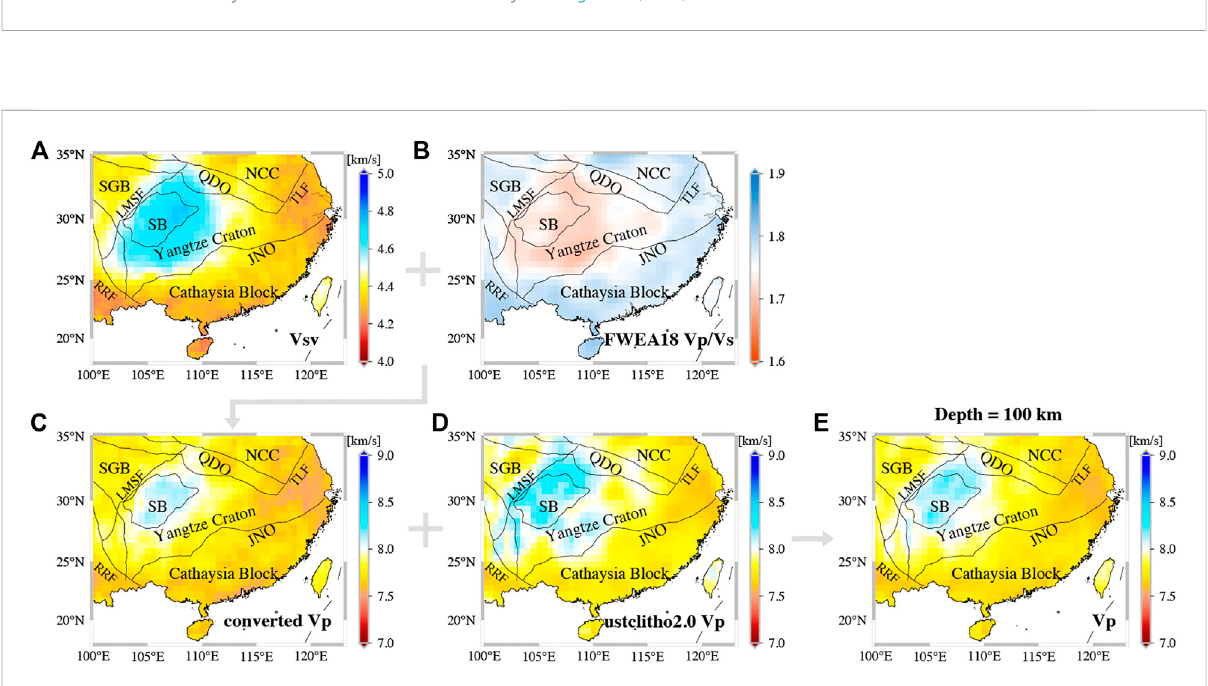
FIGURE 9 TheconstructionprocessofPwavevelocityofthemantlecomponentofSREM-SCkeyedatamapviewof100 kmdepth (C) TheconvertedPwave modelisobtainedbycombing (A) theaveragedSVwavemodelwith (B) theVp/VsratiofromtheFWEA18model(Taoetal.,2018),andthenaveragedwith (D) the P wave velocity from USTClitho2.0 model (Han et al., 2021) to build (E) the fi nal P wave velocity of the mantle component of SREM-SC.